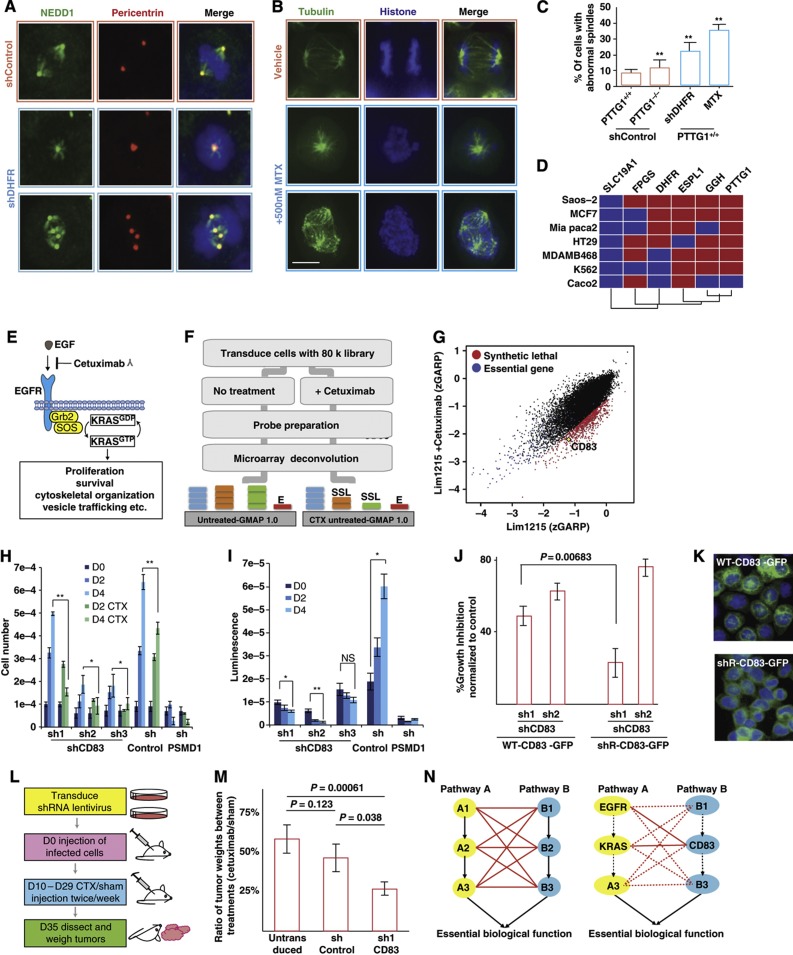
Targetable vulnerabilities revealed through genetic interactions. (A) Pericentrin (red) and NEDD1 (green) staining for centrosomes and DAPI staining (blue) to indicate nuclei in PTTG1+/+ cells depleted after the knockdown of DHFR. (B) Representative images from a live-cell experiment, where PTTG1+/+ cells were treated with 500 nM of MTX. Spindles were monitored with TUBB2C-GFP and chromosomes with H2B-BFP (see Supplementary Information for details). (C) Quantification of abnormal spindle morphology in PTTG1−/− cells expressing a negative control shRNA, shLACZ or PTTG1+/+ cells expressing shLacZ, shDHFR or treated with 500 nM MTX. At least 100 cells were analyzed for each experiment (n=3), **P<0.01, χ2-test. Scale bar, 6 μm. (D) Matrix of relative expression levels of indicated genes (columns) in isogenic cell lines (rows). Red indicates levels are up and blue levels are down in resistant versus sensitive cells. (E) Schematic depicting the effect of Cetuximab (CTX) inhibition on EGFR-RAS signaling. (F) Experimental workflow for the identification of synthetic lethal interactions with CTX in LIM1215 cells. (G) Scatter plot of zGARP scores for CTX-treated and -untreated LIM1215 cell lines from primary screens. Genes that are synthetic lethal with CTX (P<0.05) are highlighted in red, whereas genes that are essential in both untreated and treated lines are highlighted in blue. (H) Synthetic lethal effect of CTX and CD83 shRNA in LIM1215 cells. Viability/cell number is depicted relative to the negative control shLacZ. Error bars represent 1 s.d. *P<0.05 and **P<0.001 calculated using a one-tailed Student's t-test (n=3). (I) Synthetic lethal effect of CD83 knockdown on KRASG13D/− cells is shown. Viability/cell number is depicted relative to the negative control shLacZ. Error bars represent 1 s.d. *P<0.05 and **P<0.01, one-tailed Student's t-test (n=3). NS, not significant. (J) Rescue experiment showing the on-target effect of shRNAs targeting CD83, including sh1-CD83 and sh2-CD83. KRASG13D/− cells expressing GFP-tagged CD83 or CD-83-shR were counted by flow cytometry 6 days after infection with sh1-CD83, sh2-CD83 or shLacZ as a negative control. (K) Overexpression of either GFP-tagged wild-type CD83, CD83-GFP or GFP-tagged shRNA-resistant CD83 (shR-CD83-GFP) protein in KRASG13D/− cells showing correct membrane localization. (L) Experimental setup for validation of the negative genetic interaction between CTX and CD83 in an in vivo xenograft model. (M) Ten mice were dissected for each group and tumors were weighed (n=20). Error bars represent 1 s.d. (N) Schematic depicting possible genetic relationship between EGFR-KRAS and CD83.